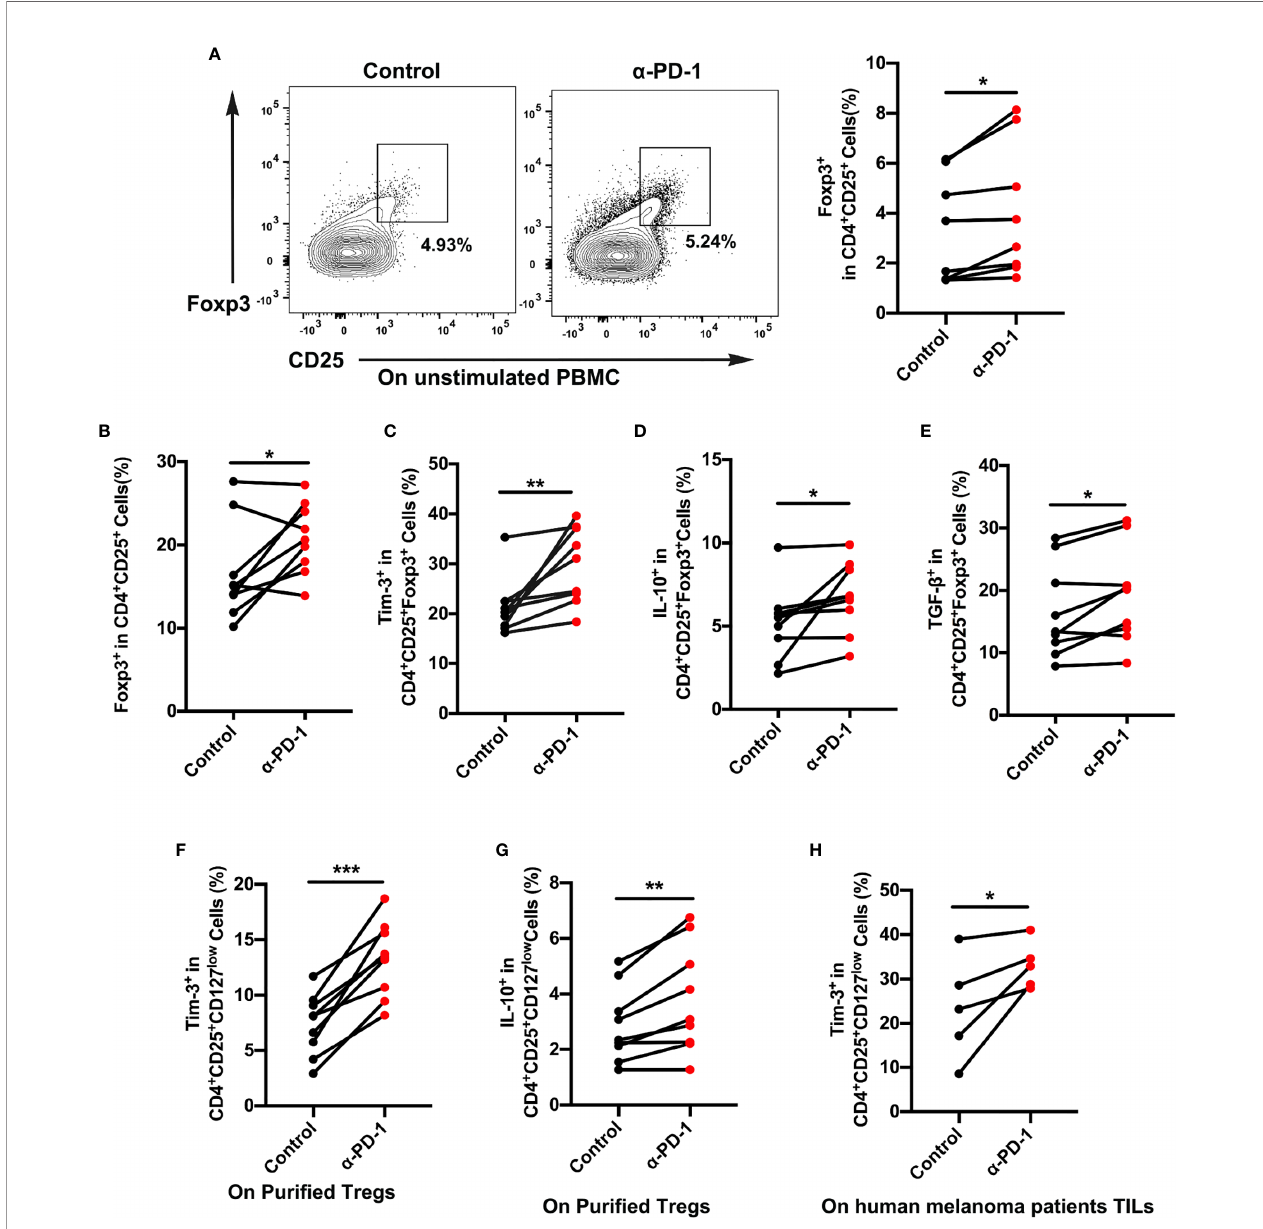
FIGURE 2 | Tim-3 expression upregulated after PD-1 blockade on Treg cells. (A, B) Anti-PD-1 antibody ( a -PD-1) was given at a concentration of 10 µg mL -1 in vitro for 48 h. The proportion of Treg cells in unstimulated (A) or (B) stimulated PBMCs were analyzed (n=9; p < 0.05). (C – E) Tim-3 expression, IL-10 and TGF- b production were investigated by fl ow cytometry. Representative Tim-3 expression (C) , IL-10 (D) and TGF- b secretion (E) in Treg cells after stimulation with PD-1 blockade (n=9; p < 0.01; p < 0.05; p < 0.05). (F, G) Puri fi ed Treg cells were subjected to anti-PD-1 therapy for 48 h. Representative plots representing Tim-3 expression (F) and IL-10 (G) in Treg cells (n=9; p < 0.001). (H) Freshly isolated tumor-in fi ltrating lymphocytes (TILs) from melanoma patients were treated with nivolumab 10 µg mL -1 for 48 h. Tumor-in fi ltrating Treg cells from melanoma patients were analyzed for Tim-3 expression (n=5; p < 0.05). Signi fi cance was calculated with a t -test. All data are presented as the means ± SEM, * p < 0.05; ** p < 0.01; *** p <